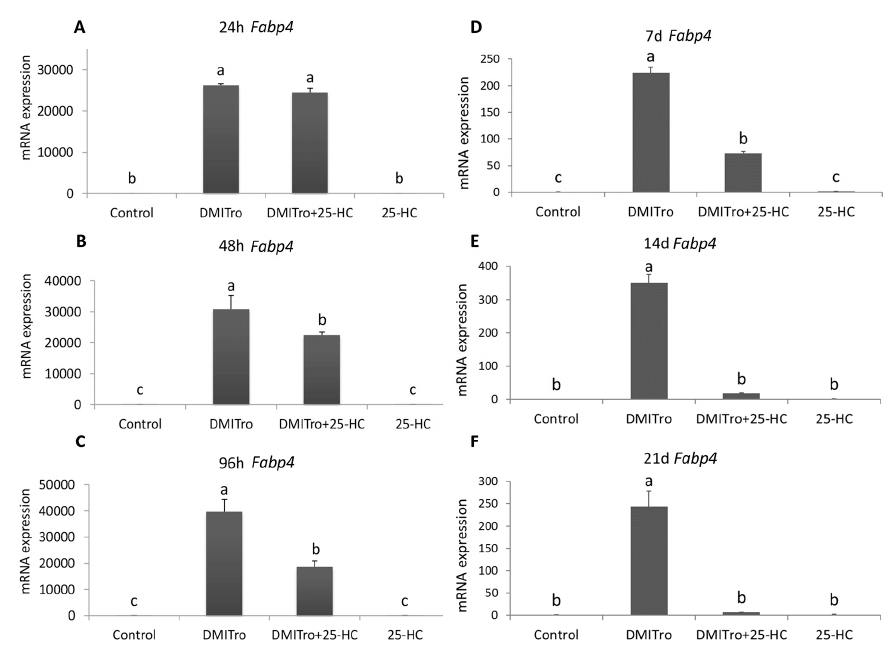
Figure 5. The effects of 25-HC on the expression of Fabp4 mRNA at different time points: ( A ) 24 hours, ( B ) 48 hours, ( C ) 96 hours, ( D ) 7 days, ( E ) 14 days, ( F ) 21 days. C3H10T1 / 2 cells at confluence were treated with a control, DMITro (500 nM DEX, 0.5 mM IBMX, 20 µ g / mL Insulin and 10 µ M Tro), DMITro + 10 µ M 25-HC or 25-HC alone for 24 h, 48 h, 96 h, 7 days (d), 14 days and 21 days. The results show the average values of three replicates ( n = 3) and the SD of the means. Bars with the same letter are not significantly different.